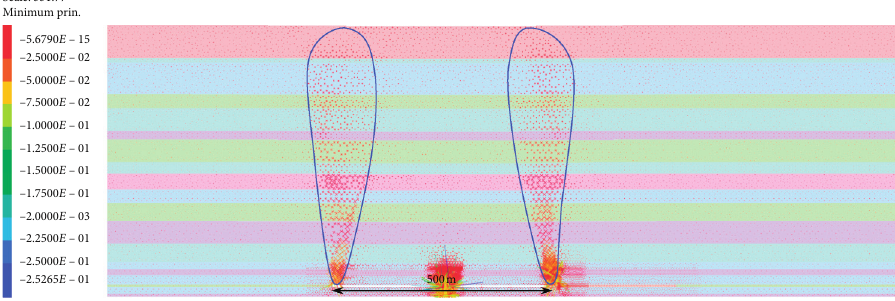
Figure 20: Strain increments of strata after extraction of 31101 panel. Strain Inc. Scale: 331.77 Minimum prin.